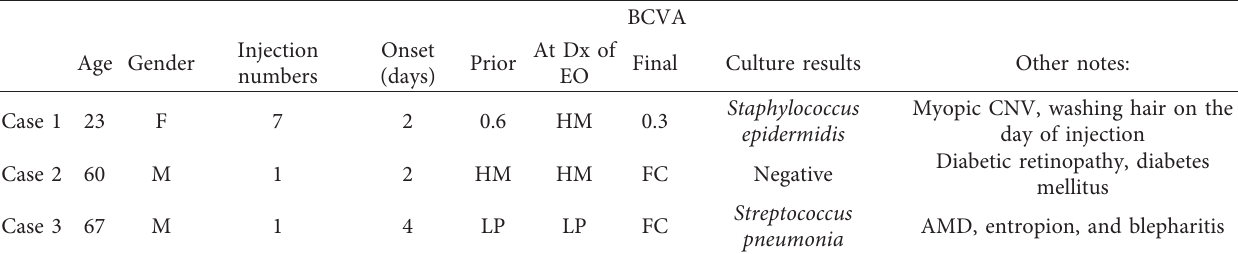
Table 1: Key data for the patients with